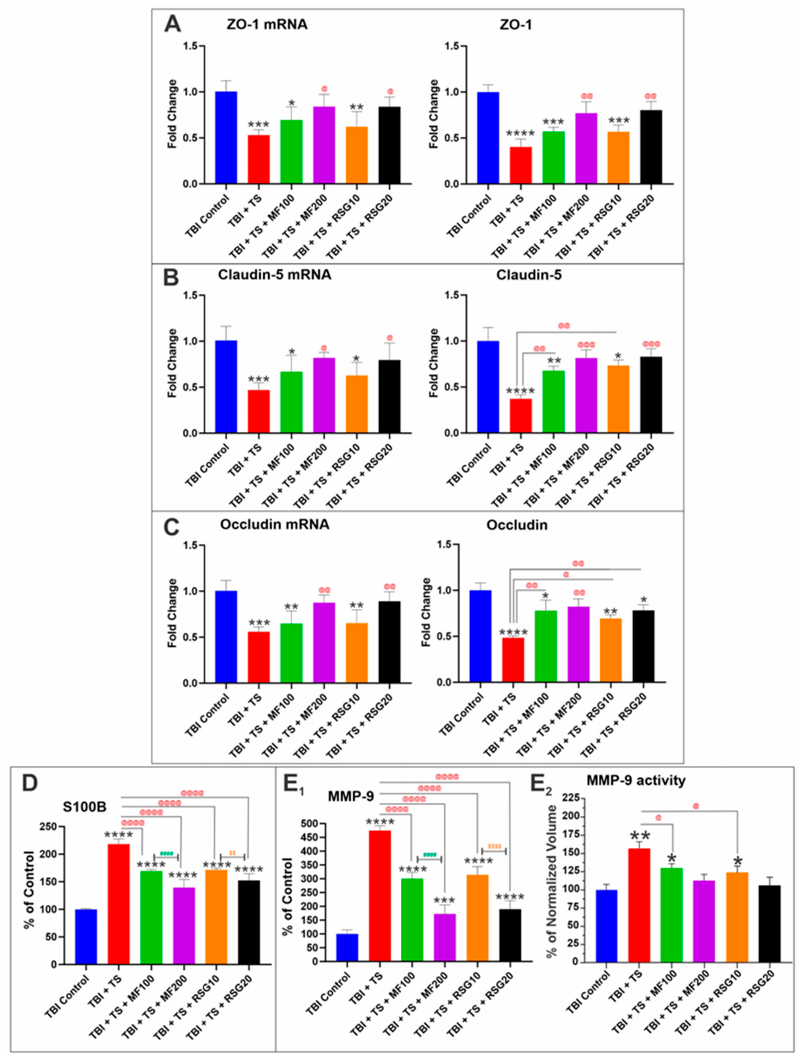
Figure 6. Dose-dependent protective effects of MF and RSG against TS and TBI-induced loss of barrier integrity. ELISA and quantitative RT-PCR analyses demonstrated upregulation of ( A ) accessory anchoring protein ZO-1 and TJ proteins, ( B ) Claudin-5, and ( C ) Occludin in MF and RSG-treated mice in a dose-dependent manner. Decreased levels of ( D ) S100B and ( E1 ) MMP-9 expression and ( E2 ) enzymatic activity as biomarkers of BBB integrity emphasized the dose-dependent protective effect of MF and RSG in mice exposed to TS and induced by TBI. n = 6 biological replicates, * p < 0.05, ** p < 0.01, *** p < 0.001, **** p < 0.0001 versus control. @ p < 0.05, @@ p < 0.01, @@@ p < 0.01, @@@@ p < 0.0001 non-treated versus MF/RSG-treated group. #### p < 0.0001 MF100 versus MF200. $$ p < 0.01, $$$$ p < 0.0001 RSG10 versus RSG20.